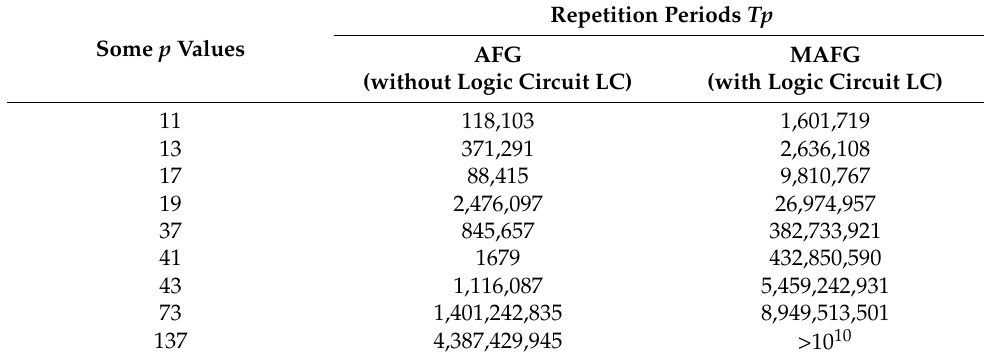
Table 2. Repetition periods of AFG and MAFG output sequences for some p values when X (0) = 1.